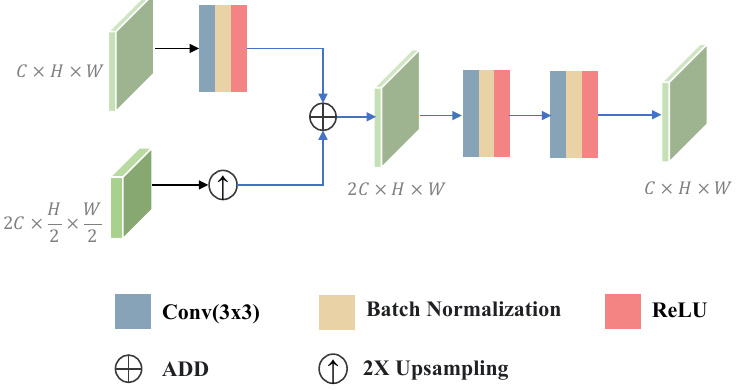
Figure 7. Illustration of the structure of the Smooth Fusion